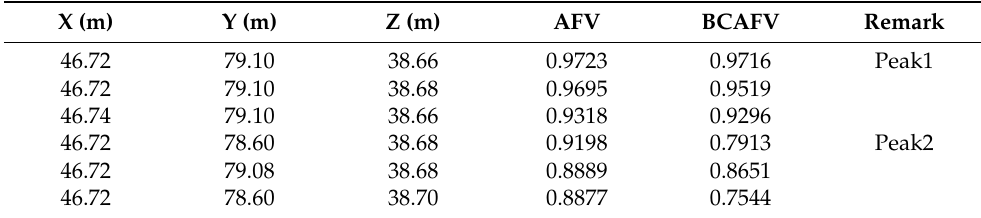
Table 5. Several large AFVs and BCAFVs and corresponding coordinates in epoch 03:05:15. X